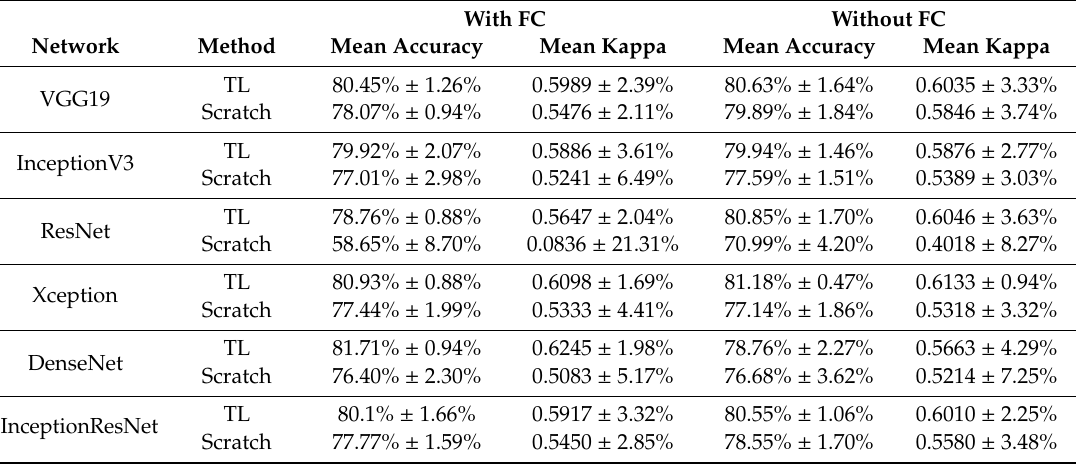
Table 3. Accuracy and Kappa scores of classifying wrist images with and without fully connected layers ( ± 95% CI).